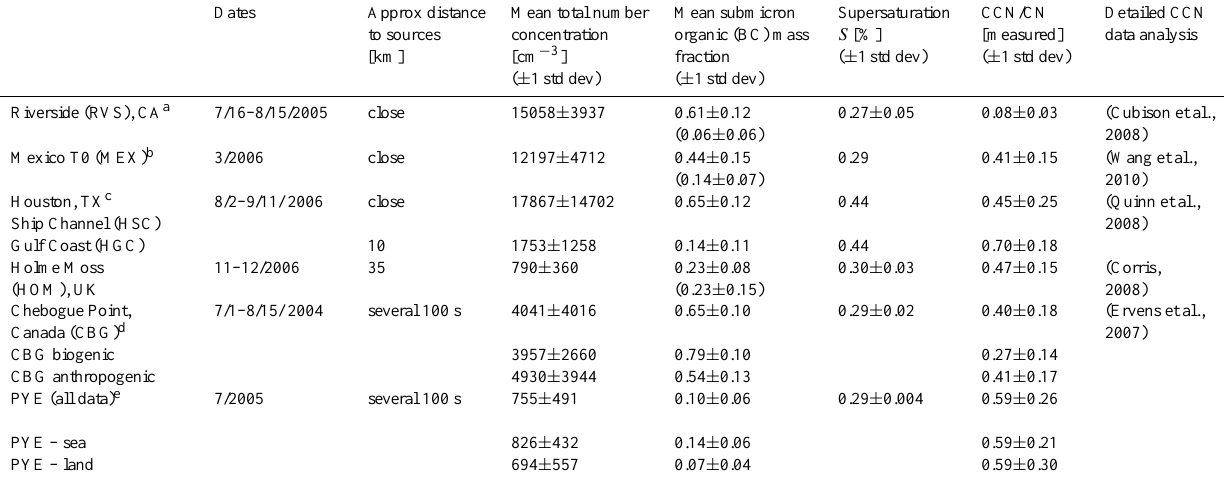
Table 1. Characteristics of the data sets that have been used for CCN closure in the current study.